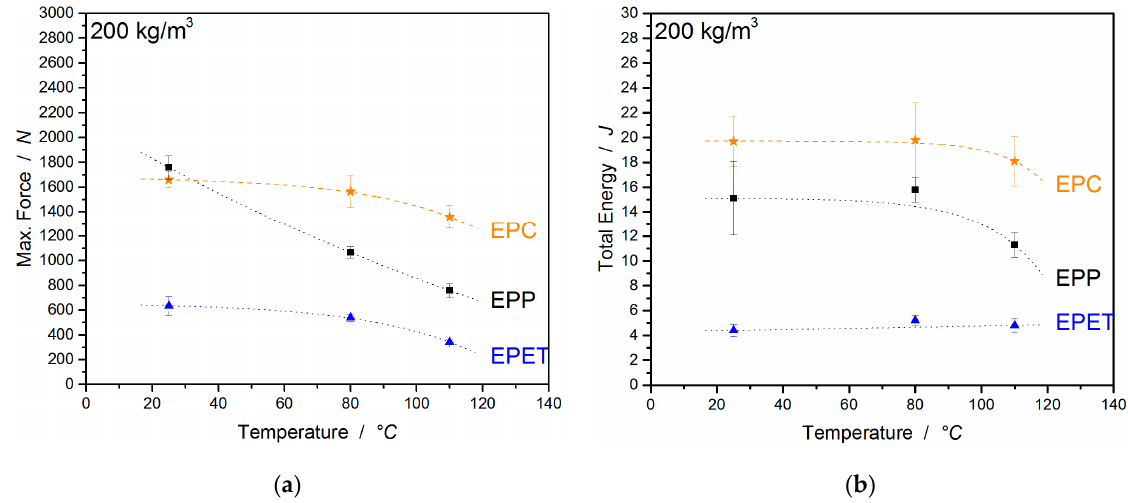
Figure 13. Comparison of impact force ( a ) and energy absorption ( b ) of EPC, EPP, and EPET at RT, 80, and 110°C.